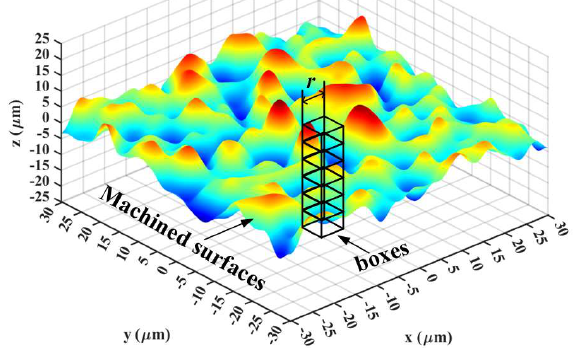
Figure 1. Schematic of fractal dimension calculation using the 3D Box-counting